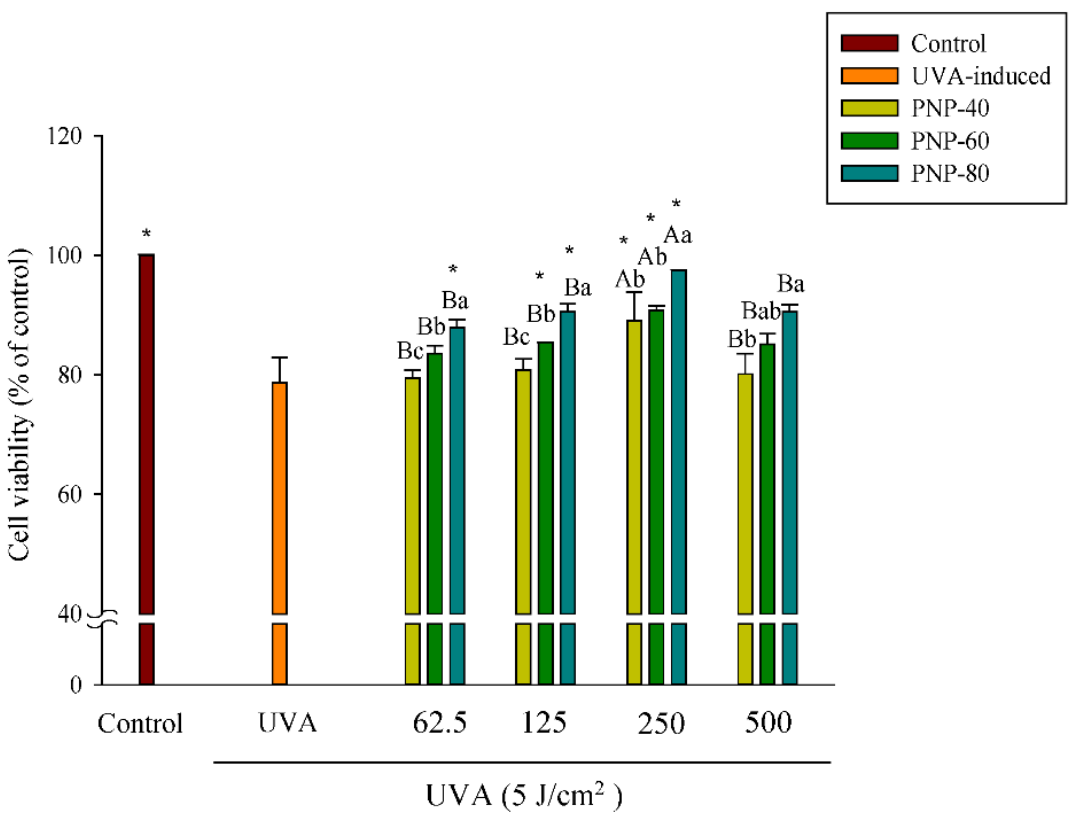
Figure 4. Cell viability of Hs68 cells pretreated with PNPs (62.5, 125, 250, and 500 μg/mL) for 24 h and then subjected to UVA irradiation at 5 J/cm 2 , as determined via MTT assay. Experiments were conducted in triplicate ( n = 3). Data are expressed as the mean ± SD. * Significant differences com- pared to the UVA-induced group ( p < 0.05). a – c: Matching lowercase letters between samples at the same concentration indicate significant differences between the samples at that concentration ( p < 0.05). A,B: Matching uppercase letters for the same sample at different concentrations indicate sig- nificant differences for that sample between different concentrations ( p < 0.05).